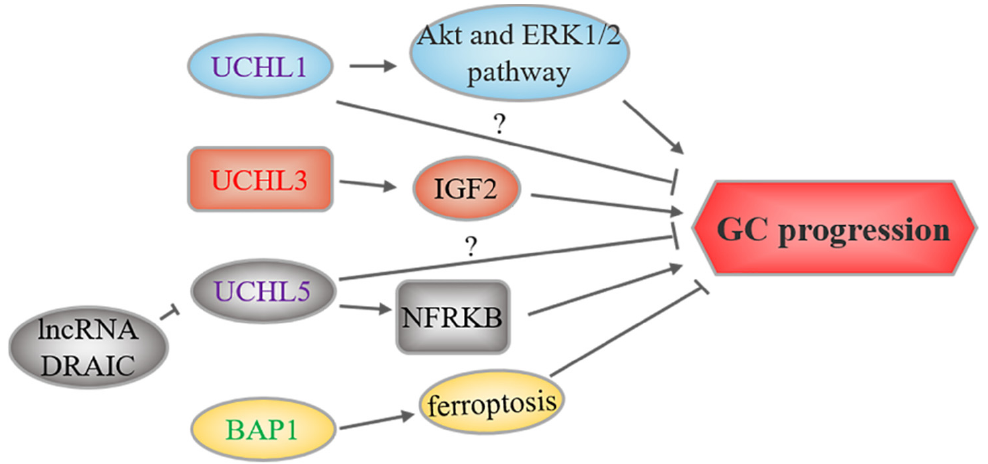
Figure 3. UCH-related upstream regulation and downstream mechanisms in GC. UCHs marked in red and green represent oncoproteins and tumor suppressors, respectively, while purple-labeled UCHs play a dual role. The text to the left and right of the UCHs corresponds to the upstream regulatory events and downstream substrates or signaling pathways, respectively.